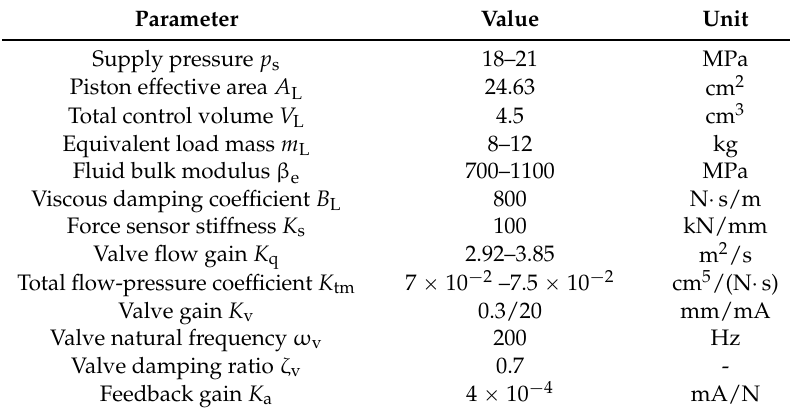
Table 1. Parameters of the loading